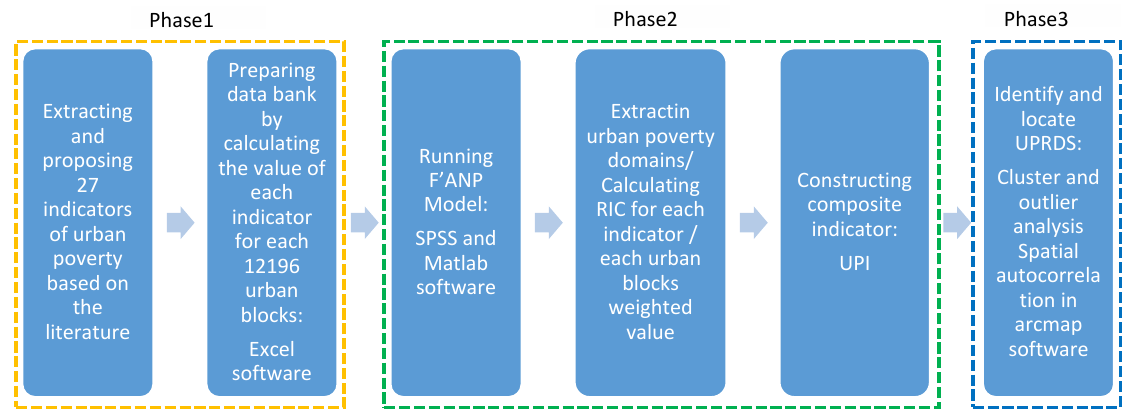
Fig.2: Areas developed through the evolution of Isfahan Metropolis; adapted from Atlas of Isfahan Metropolis (Atlas of Isfahan Metropolis, 2017 )